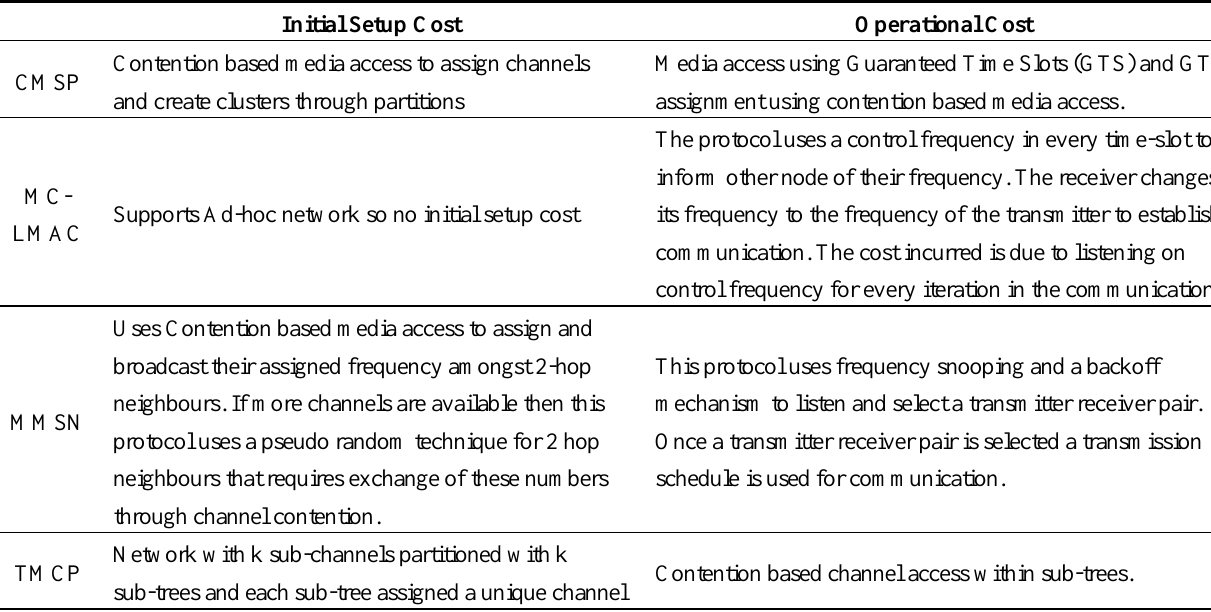
Table 4. Comparison of setup and operational cost for different